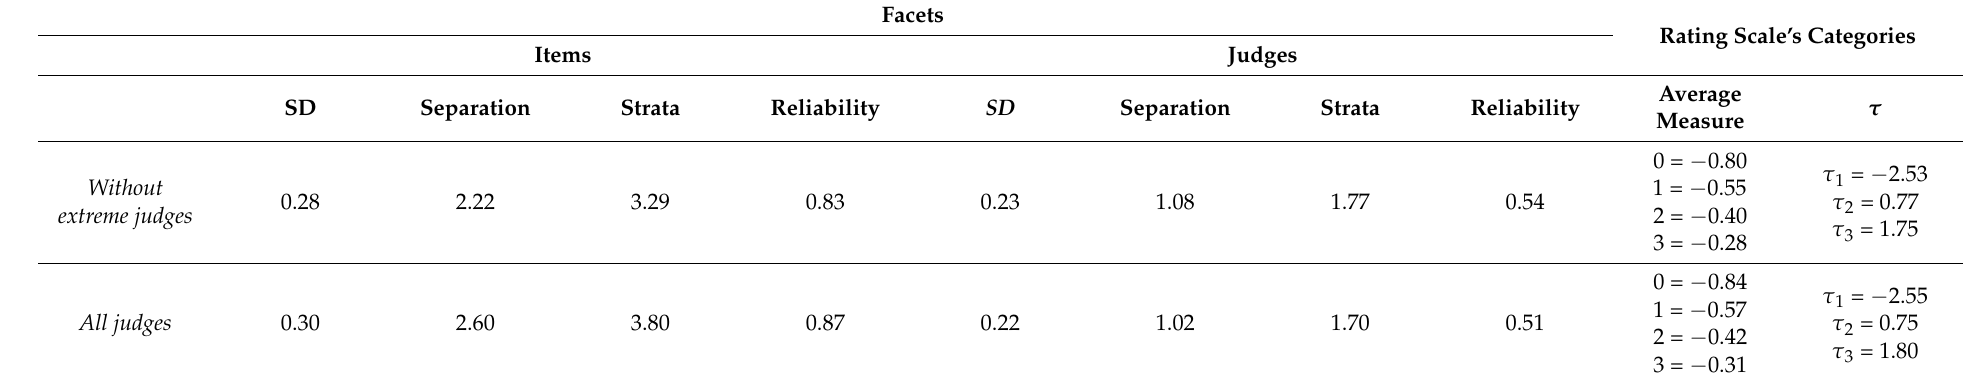
Table 8. Data fit to the MFRM model after collapsing